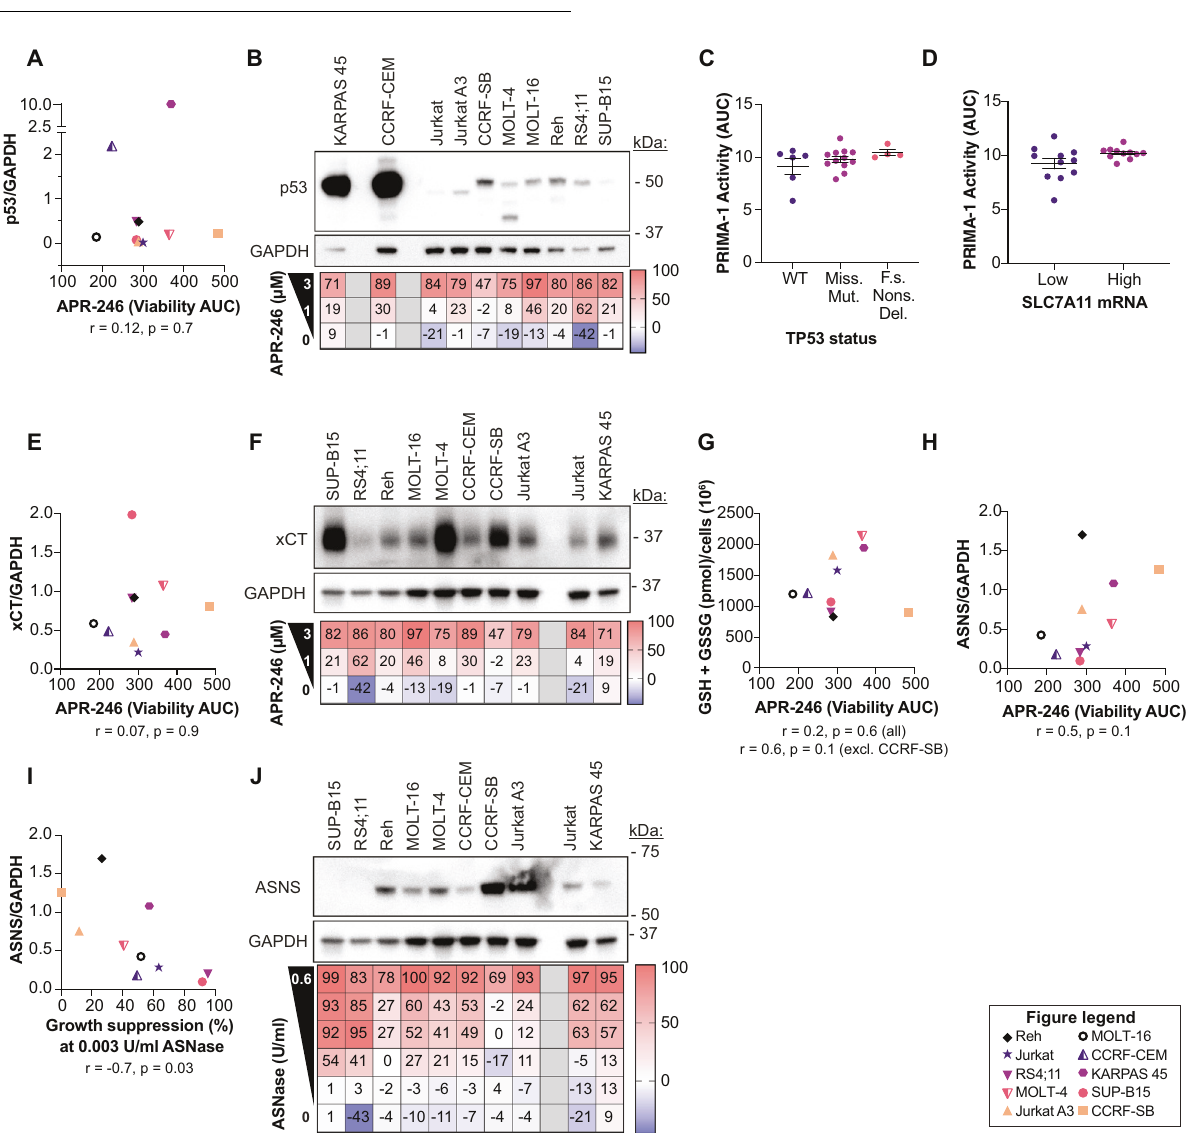
Fig. 3 Markers for ASNase and APR-246 sensitivity in ALL cells. A p53 protein levels in untreated cells plotted against cell viability after 72 h treatment with APR-246. p53 levels were obtained by quanti fi cation of the western blot in B . Cell viability was assessed by resazurin (area under the curve [AUC]). See Table S5. Spearman correlation r = 0.12, p = 0.7. B Western blot of untreated ALL cell lines and a heat map indicating growth suppression as assessed by resazurin after 72 h of APR-246 treatment. C Analysis of data from the DepMap portal of the Broad Institute of 22 ALL cancer cell lines showing PRIMA-1 activity area under the curve (AUC) grouped into TP53 status. WT = wild type, Miss. Mut. = missense mutation, F.s. = frameshift, Nons. = nonsense, Del. = deletion D Analysis of data from the DepMap portal of the Broad Institute of 22 ALL cancer cell lines showing PRIMA-1 activity area under the curve (AUC) grouped into xCT/SLC7A11 mRNA expression below or above median. Unpaired t test, p = 0.08. E xCT protein levels in untreated cells plotted against cell viability after 72 h treatment with APR-246. xCT levels were obtained by quanti fi cation of the western blot in F . Cell viability was assessed by resazurin (area under the curve [AUC]). See Table S5. Spearman correlation r = 0.07, p = 0.9. F Western blot of untreated ALL cell lines and a heat map indicating growth suppression as assessed by resazurin after 72 h of APR-246 treatment (same as in B but in different order). G Total glutathione (GSH + GSSG) measured by enzymatic recycling assay in untreated ALL cell lines after 72 h in culture plotted against cell viability after 72 h of APR-246 treatment. Cell viability was assessed resazurin (area under curve [AUC]). Cell lines are speci fi ed in the fi gure legend box. See Table S5. Spearman correlation r = 0.2, p = 0.6 or excluding CCRF-SB r = 0.6, p = 0.1. H ASNS protein levels in untreated cells plotted against cell viability after 72 h treatment with APR-246. ASNS levels were obtained by quanti fi cation of the western blot in J . Cell viability was assessed by resazurin (area under the curve [AUC]). See Table S5. Spearman correlation r = 0.5, p = 0.1. I ASNS protein levels in untreated cells plotted against growth suppression after 72 h treatment with 0.003 U/ml ASNase. ASNS levels were obtained by quanti fi cation of the western blot in J . Growth suppression (%) was assessed by resazurin. See Table S4. Spearman correlation r = − 0.7, p = 0.03. J Western blot of untreated ALL cell lines and a heat map indicating growth suppression as assessed by resazurin after 72 h of asparaginase (ASNase) treatment. Detailed information and n regarding growth suppression are given in Table S4. The same GAPDH control blot is shown in panels F and J since both xCT ( F ) and ASNS ( J ) were examined on the same blot. The blot was divided into an upper part which was probed with ASNS antibody and a lower part which was probed with xCT antibody and then re-probed with GAPDH antibody. Thus, the same GAPDH blot serves as control for both xCT and ASNS.